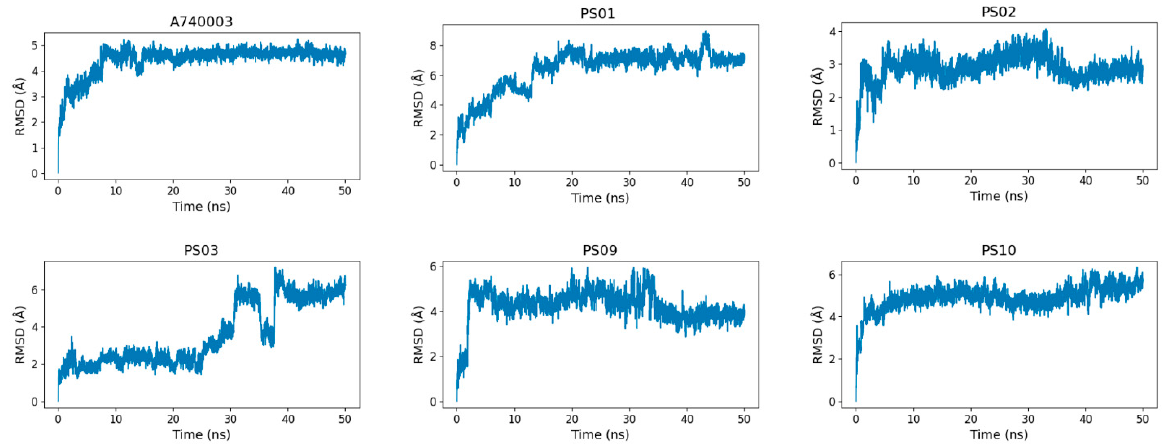
Figure 8. RMSD (root ‐ mean ‐ square deviation) variation of the ligands (A740003, PS01, PS02, PS03, PS09, and PS10) in relation to the P2X7 receptor during 50 ns of molecular dynamics simulation.